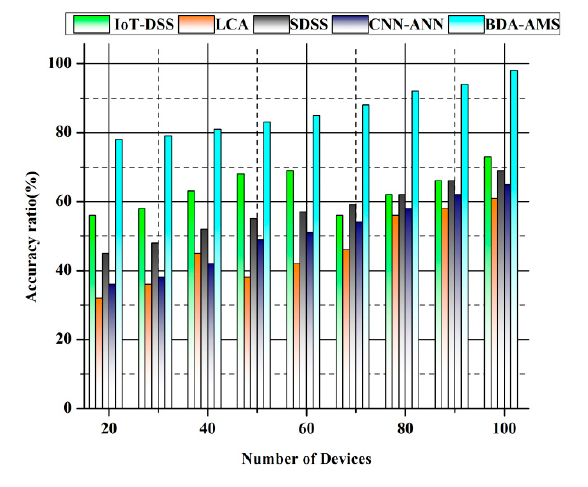
Figure 11. Accuracy ratio (%).